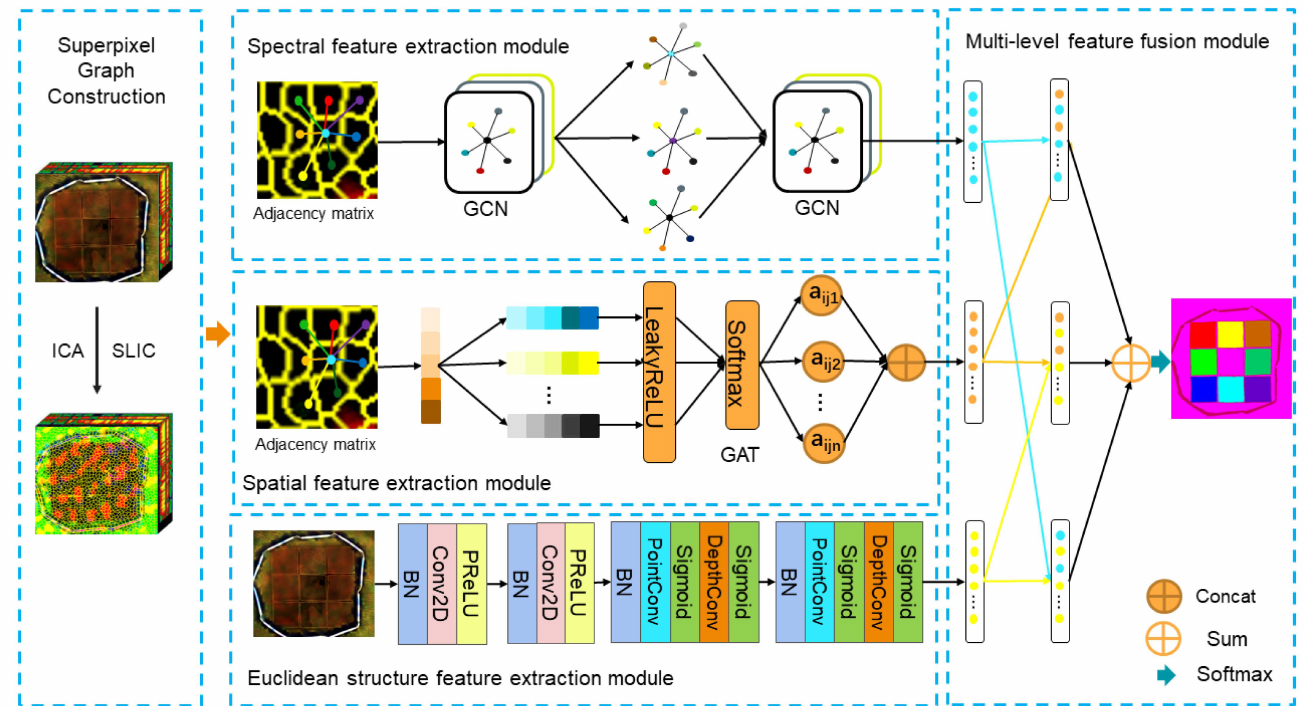
Figure 1. The architecture of the proposed model for oil spill